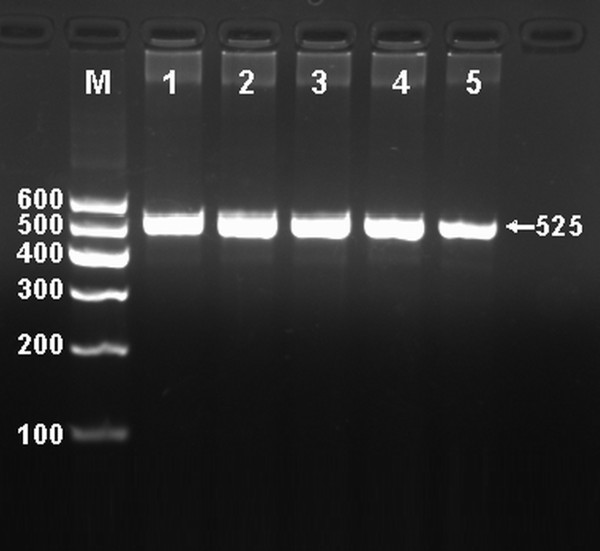
Electrophoresis of PCR products of the samples. Lane M, 100 bp marker ladder; lanes 1-5, samples. The 525 bp bands are the target genes.